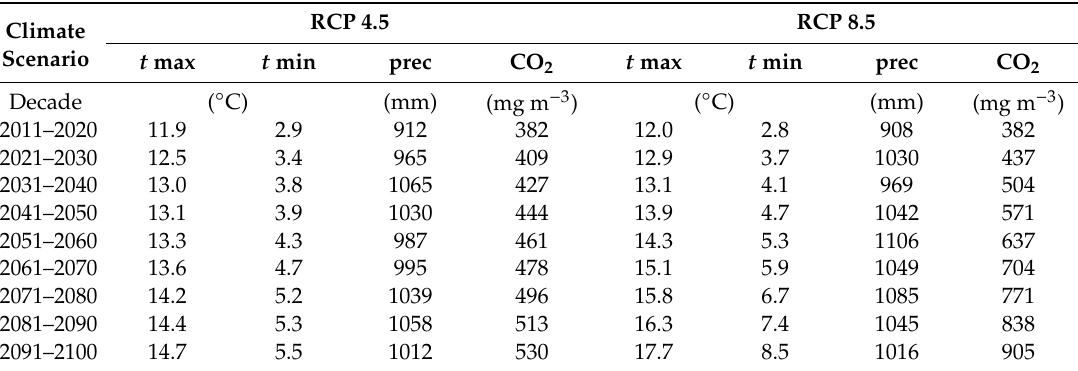
Table 1. Predicted air temperatures ( ◦ C), precipitation (mm) and air CO 2 concentrations (up to 2100) for two representative concentration pathways (RCP 4.5 and 8.5) for Elora, ON, Canada. [34,39]. ( t max = temperature maximum, t min = temperature minimum, prec = precipitation).